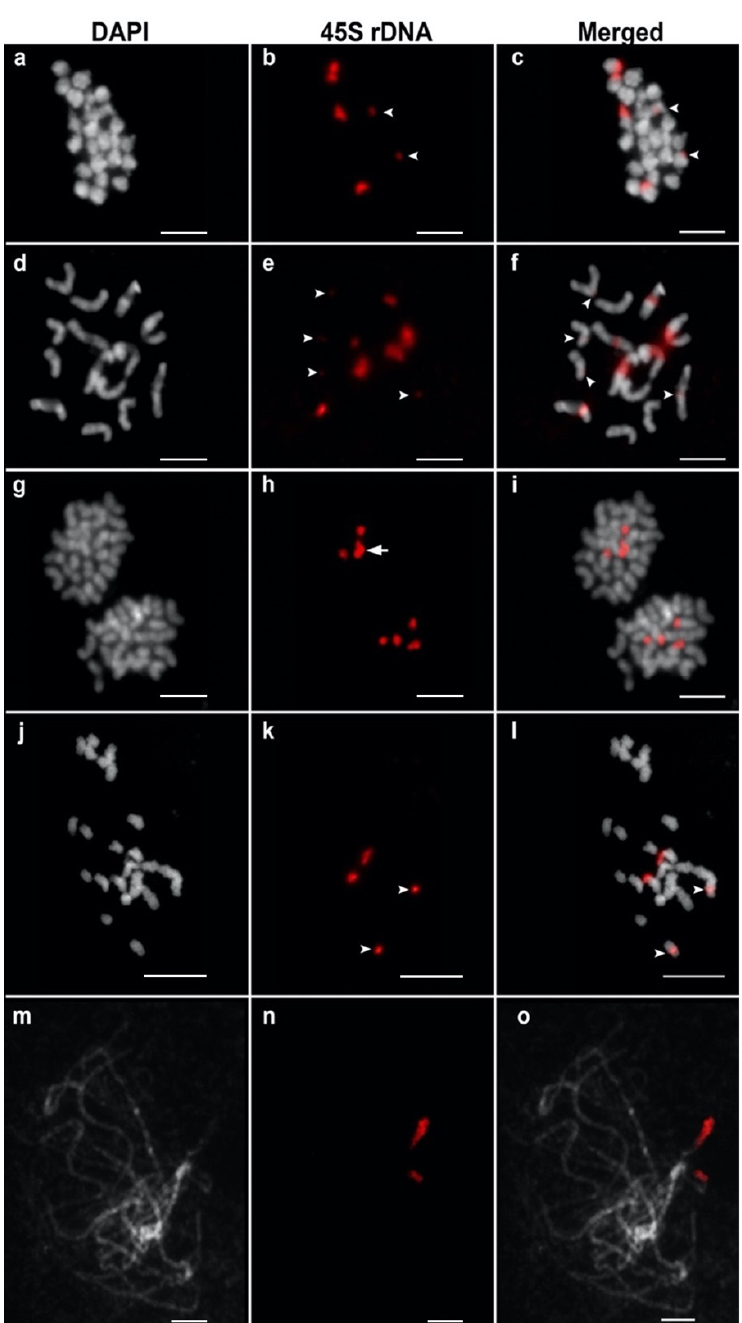
Figure 2. Physical mapping of 45S rDNA on mitotic and meiotic chromosomes of Cucumis species. C. hystrix ( a – c ), C. sativus “RAR 930024” ( d – f ), C. metuliferus “US 143” ( g – i ), C. melo “P90” ( j – l ), and C. melo “US205” ( m – o ) were stained with DAPI and subjected to fluorescent in situ hybridization (FISH) with the 45S rDNA probe (red). Arrow heads depict the minor signals of 45S rDNA. Arrow depicts the overlapped 45S rDNA loci. Scale bars = 10 μ m.